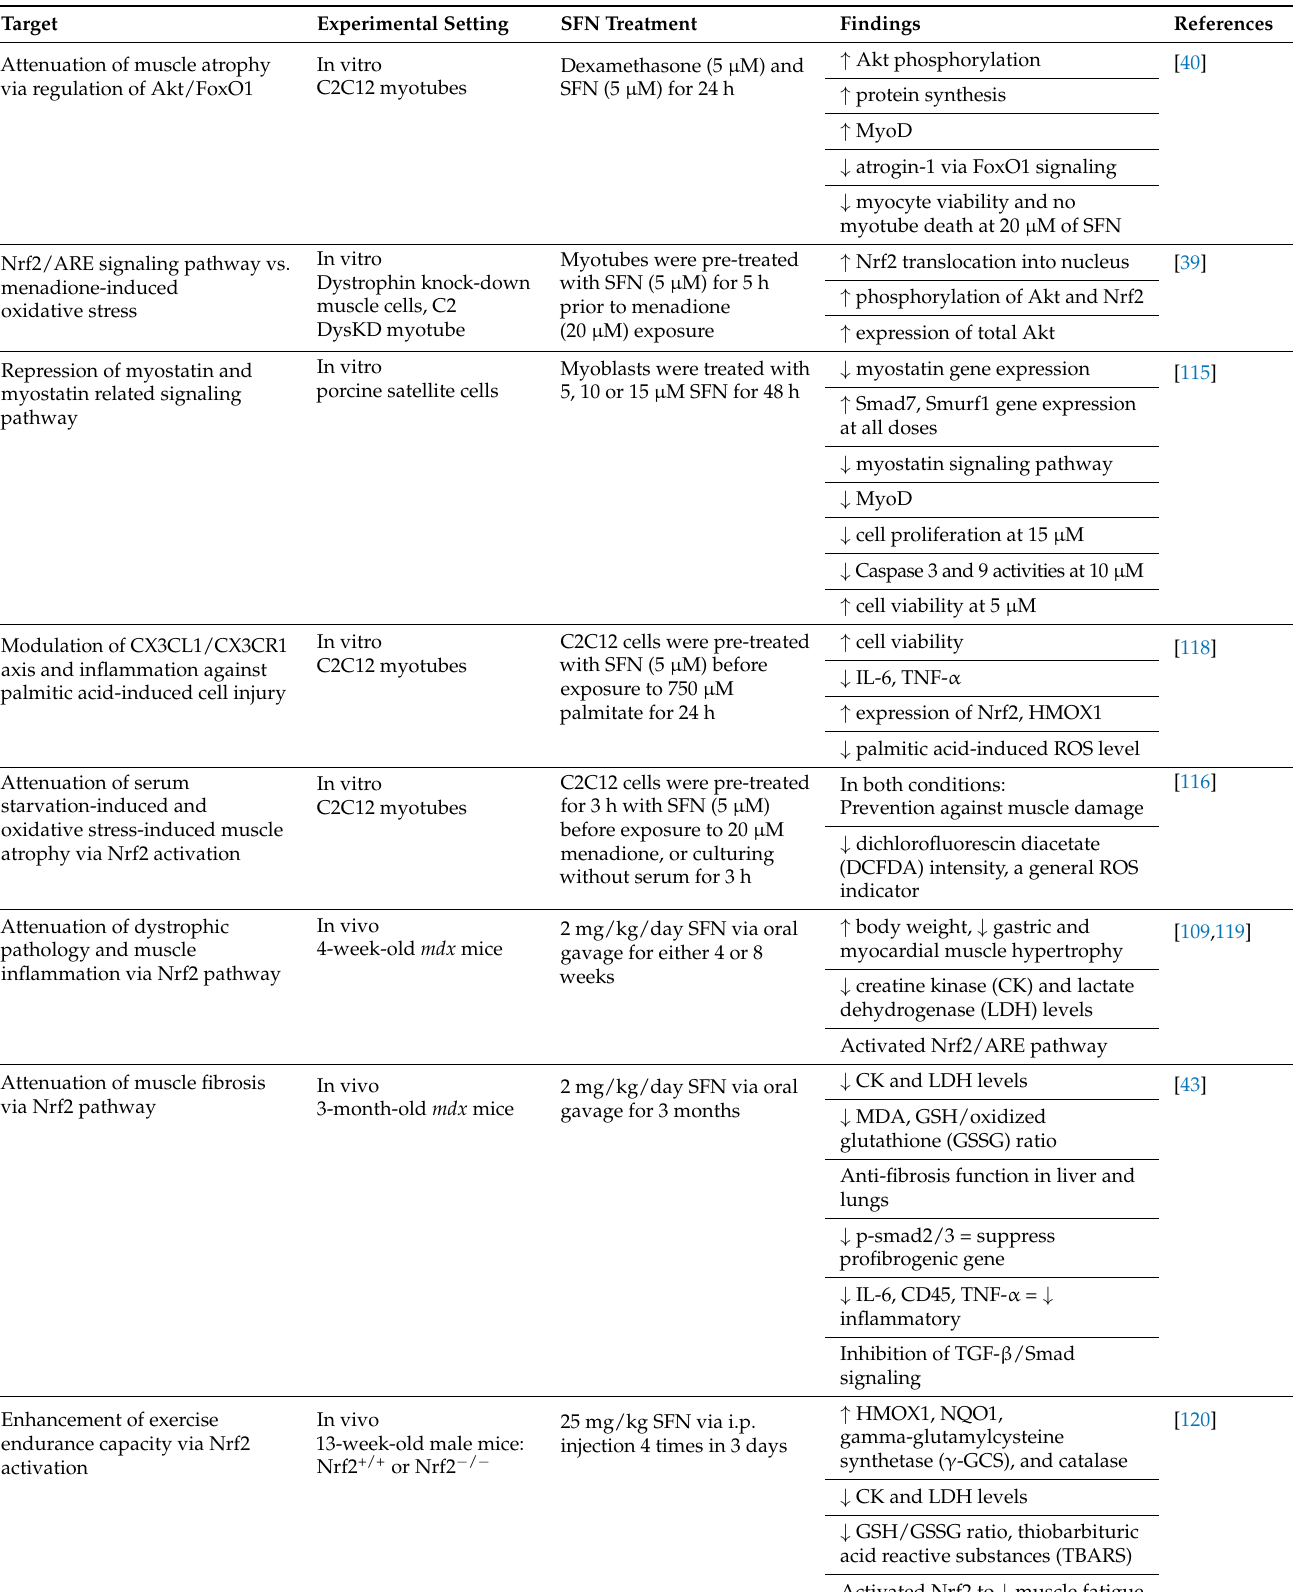
Table 3. Effects of SFN on skeletal muscle in vivo and in